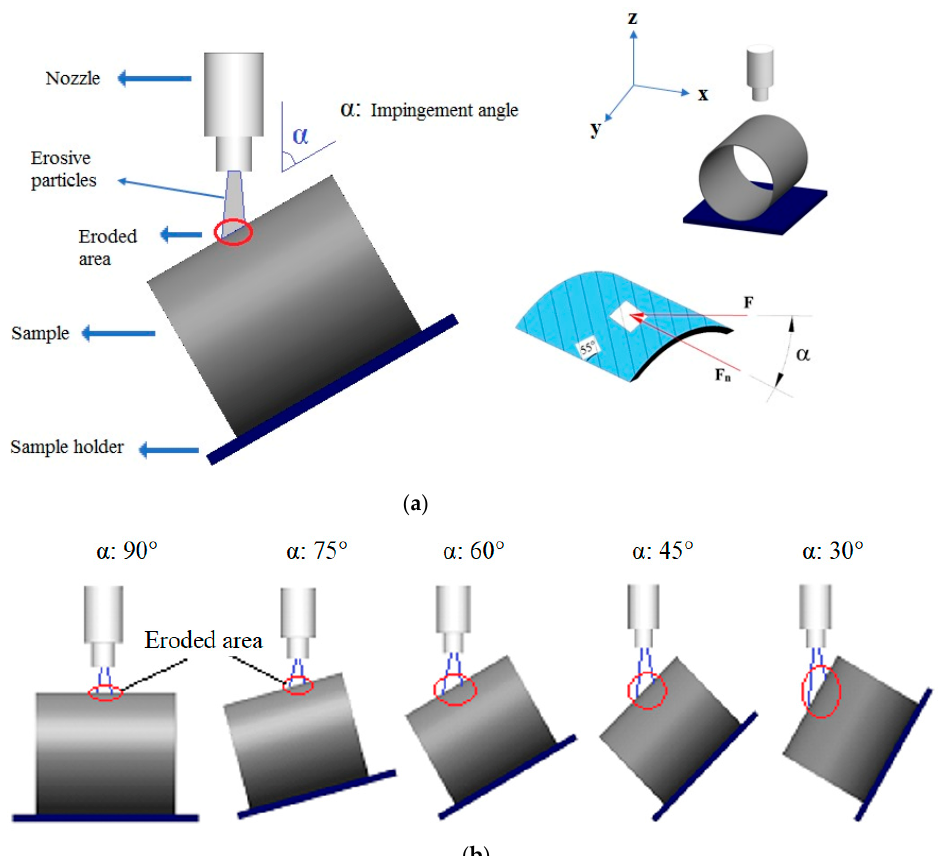
Figure 3. Pipe outer surface axial positioning test details: ( a ) SPE wear test design, and ( b ) schematic views of the variation of the impingement angle in the experiments (F: impact force, F n : normal force on laminate).